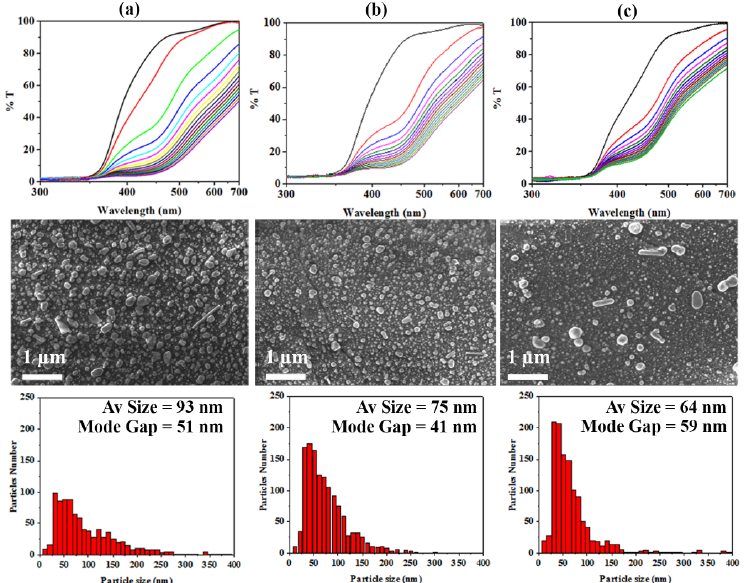
Figure 5. UV–Vis transmittance spectra showing the plasmonic dip evolution from 0 min. (black curve, water filled chip) to the final reaction time, with 1 minute step (the same colour sequence is used in all graphs, starting from the red curve, corresponding to the silver precursor injection), FESEM micrographs, and particle size distribution of the samples synthetized in dynamic conditions using a 10 mM AgNO 3 at 20 ◦ C employing a flow rate of ( a ) 1 mL/min, ( b ) 2 mL/min, and ( c ) 3